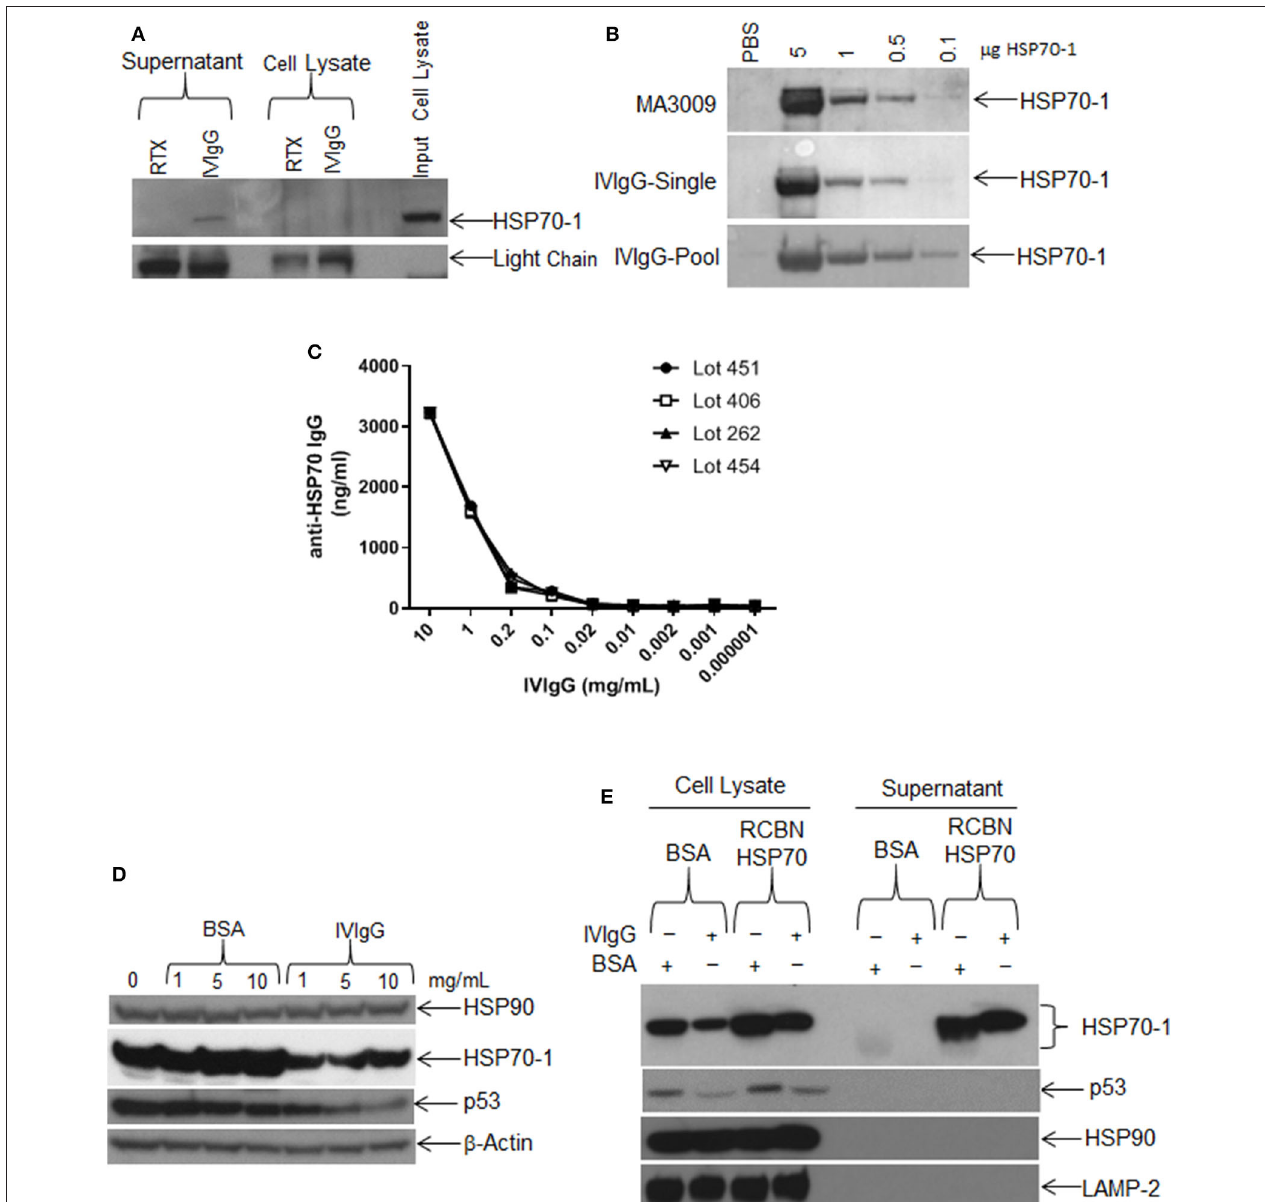
FIGURE 5 | Single IVIgG lots contain high titers of anti-HSP70 IgG. (A) RPMI 8226 cells were treated for 24h with rituximab (RTX) or IVIgG and culture media was immunoprecipitated with protein A/G agarose and immunoblotted for HSP70-1. (B) A single lot of IVIgG or multiple pooled lots were screened against increasing concentrations of recombinant HSP70-1 and compared to a commercially available anti-HSP70 IgG (MA3009). (C) Individual IVIgG lots were screened for anti-HSP70 IgG titers using a commercial ELISA and the concentration calculated for each lot. (D) RPMI 8226 cells were treated for 48h with increasing concentrations of BSA vs. IVIgG and immunoblotted for the indicated targets. (E) RPMI 8226 cells were incubated for 24h with BSA or IVIgG (10 mg/mL) in the presence of 50 µ g of recombinant (RCBN) HSP70-1 and cell lysates of culture supernatant were immunoblotted as indicated.